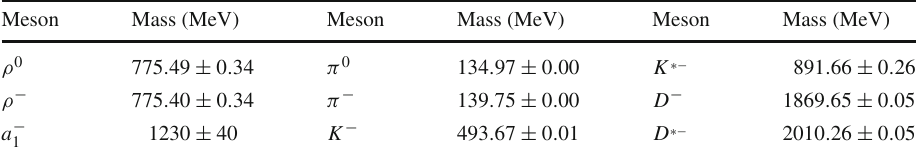
experimental values are reported in [66,67]